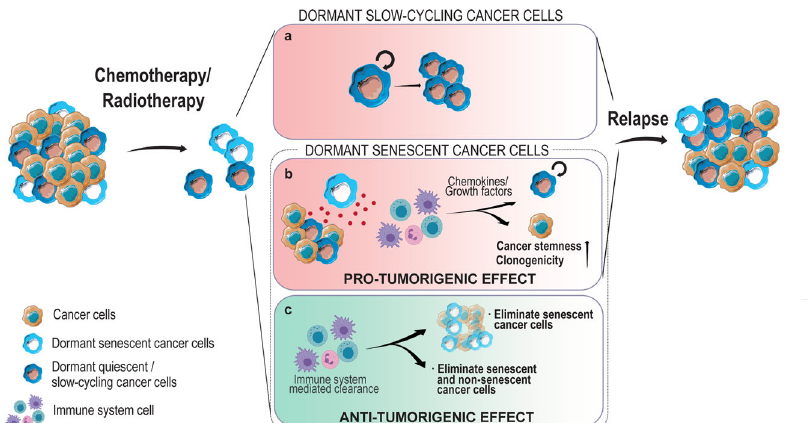
Fig. 1 Schematic representation of the hypothesis of the intratumoural heterogeneity and the effects of anti-proliferative therapies. Most frequently used anti-proliferative therapies are meant to eliminate rapid-proliferative cancer cells. The remaining dormant cell-driven relapse mechanisms differ depending on whether the cells involved are quiescent/slow-cycling or senescent. a Dormant-quiescent/slow-cycling cells can re-enter the cell cycle in response to appropriate microenvironment changes or SASP signals secreted by senescent cells. Dormant senescent cancer cells can have pro- or anti- tumorigenic effects mainly depending on the SASP content and hence, recruiting immune cells. b Although dormant-senescent cells have apparently undergone irreversible growth arrest, their SASP secretion induces slow-cycling cell proliferation, mainly mediated by immune cell recruitment, and induces clonogenicity and cancer stemness in neighbouring cells. c Alternatively, immune system cells recruited by SASP may eliminate senescent cancer cells, or eliminate both senescent and non-senescent cancer cells, causing tumour eradication 39